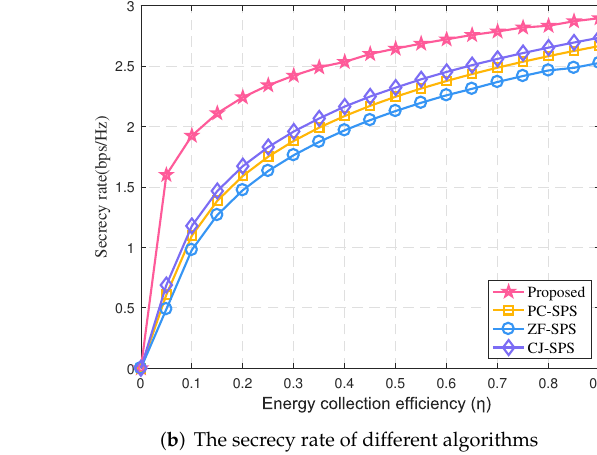
( b ) The secrecy rate of different algorithms